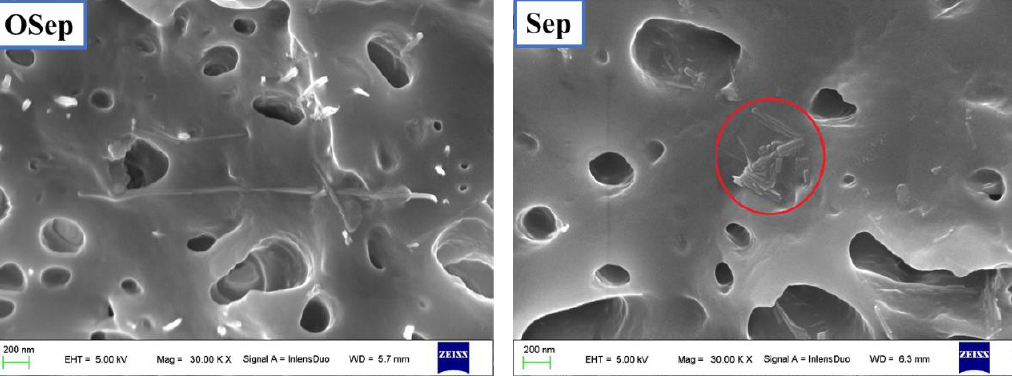
Figure 3. Morphology of PP/OSep-4 and PP/Sep-4 nanocomposites. It is the sepiolite in the red circle.